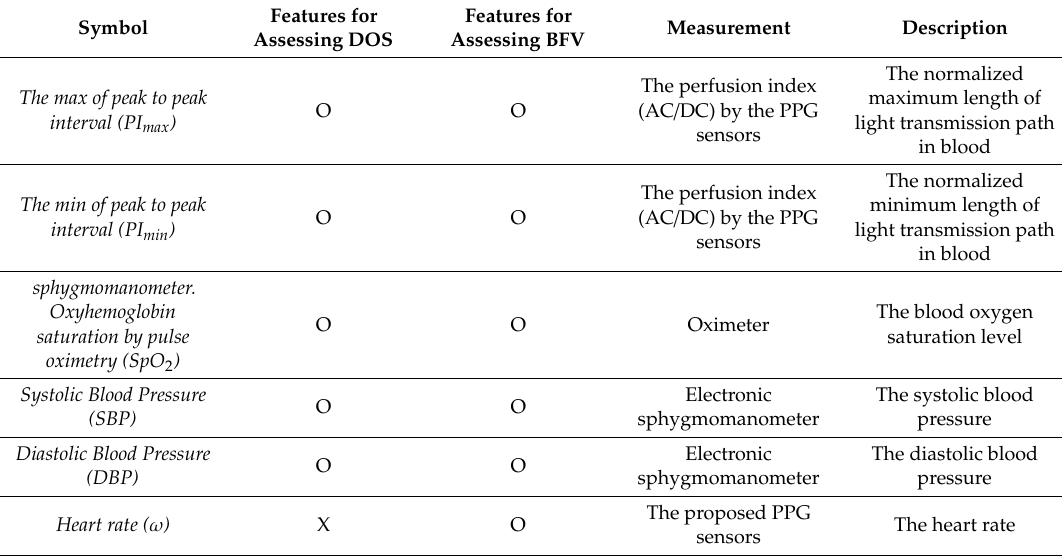
Table 1. The input features for assessing DOS and